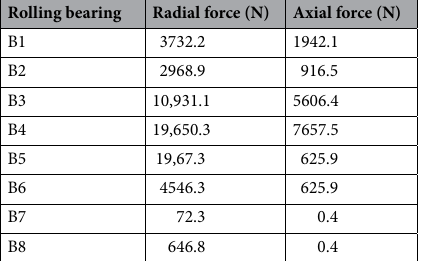
Rolling bearing